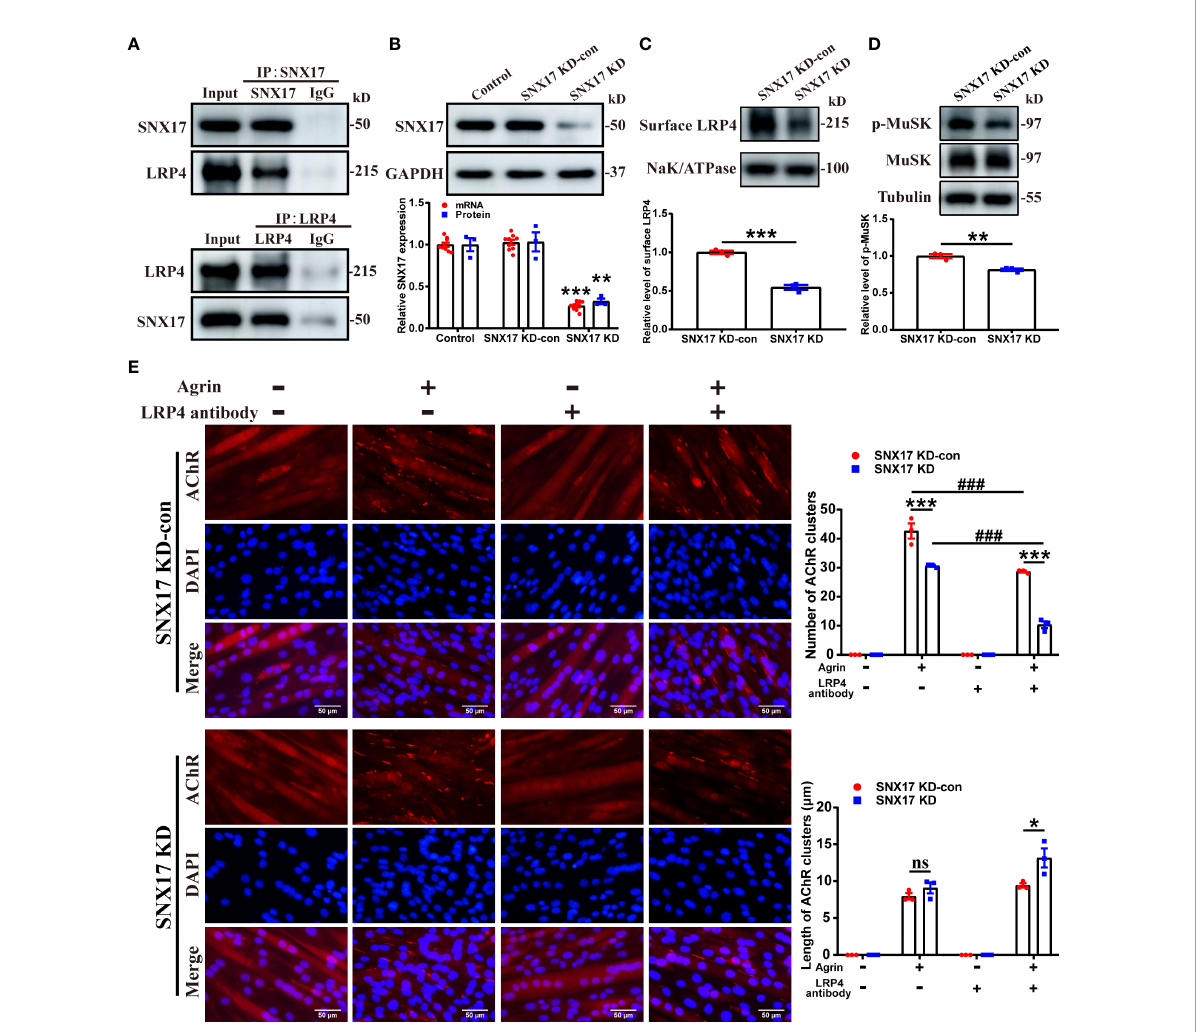
FIGURE 2 SNX17 knockdown decreased cell surface LRP4 expression, MuSK phosphorylation, and AChR aggregation. (A) Cell lysates were immunoprecipitated with antibodies against SNX17, LRP4, or control IgG. The LRP4 and SNX17 proteins in immunoprecipitation and input were analyzed by western blotting. (B) Western blotting and qPCR detection of SNX17 protein (n = 3/group) and mRNA (n = 9/group) expression, respectively, in lentivirus-infected cells. (C) Myotube cells were treated with 10 m g/mL anti-LRP4 antibody for 30 min to induce internalization of LRP4 protein on the membrane, following which the anti-LRP4 antibody was removed and the cells were cultured for 30 min, and then the content of LRP4 protein in the membrane protein was analyzed by Western Blotting. n = 3/group. (D) Myotube cells were treated with 10 m g/mL anti-LRP4 antibody for 30 min, after which the anti-LRP4 antibody was removed, the cells were incubated with 10 ng/mL Agrin for 16 h, and the expression of MuSK and p-MuSK in total protein was analyzed by Western Blotting. n = 3/group. (E) AChR clusters (red) on lentivirus-infected C2C12 myotubes were labeled with R-BTX after application of separate or mixed Agrin and anti-LRP4 antibody, the nuclei were stained with DAPI (blue), and the number of AChR clusters on myotubes was counted and the length of AChR clusters was analyzed by ImageJ software. n = 3/group; Scale bar = 50 m m. * represents SNX17 KD-con vs. SNX17 KD, # represents -LRP4 antibody vs. +LRP4 antibody. All data are presented as mean ± SEM. * P <0.05, ** P <0.01, *** P <0.001, ### P <0.001. AChR, acetylcholine receptor; EAMG, experimental autoimmune myasthenia gravis; LRP4, low-density lipoprotein receptor-related protein 4; MuSK, muscle-speci fi c receptor tyrosine kinase; R-BTX, rhodamine-labeled bungarotoxin; SEM, Standard Error of Mean; SNX17, sorting nexin 17. ns, no signi fi